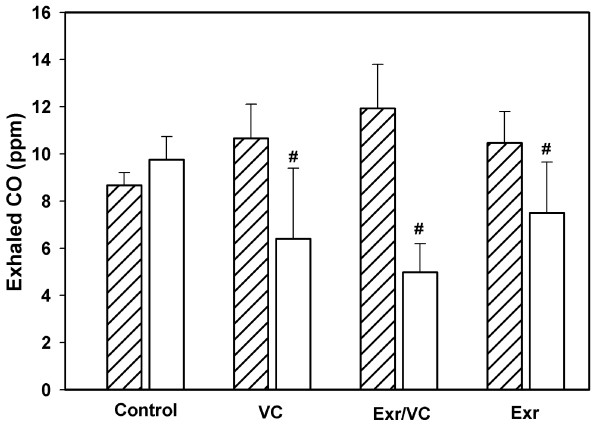
The exhale carbon monoxide (CO) between pre- (oblique line) and post-(no line) intervention periods in each group, control, VC, exercise with VC, and exercise only. Each bar represented the mean and standard deviation, and significant level at p < 0.05 (#).